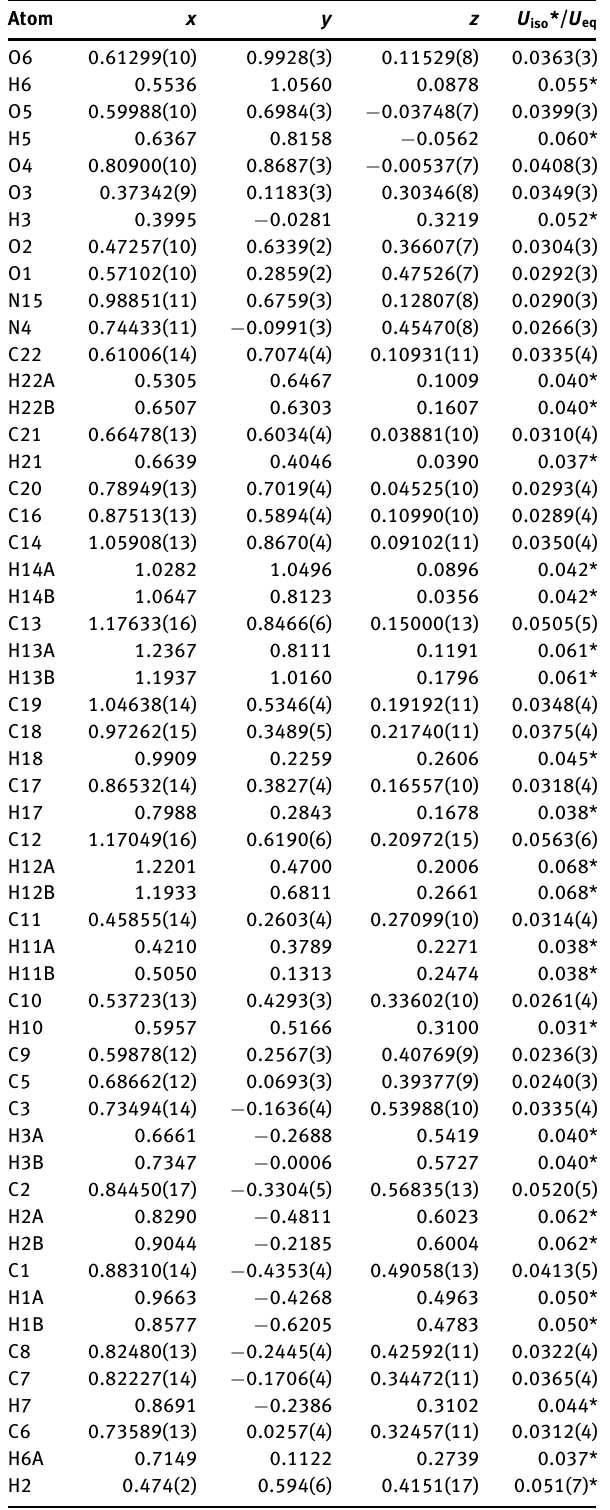
Table 2: Fractional atomic coordinates and isotropic or equivalent isotropic displacement parameters (Å 2